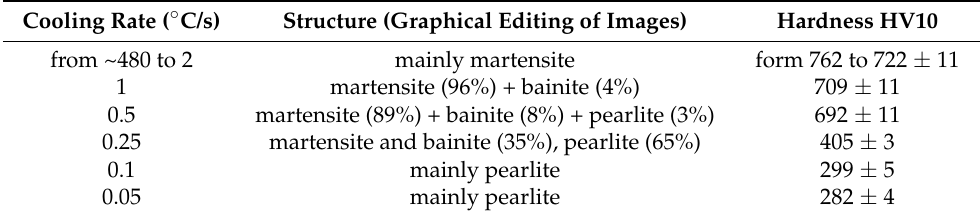
Table 3. Quantitative data of performed thermal cycles (continuous cooling) considering phase fractions and